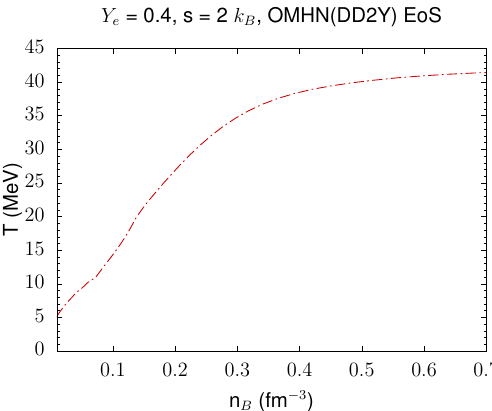
Figure 2. The temperature at constant entropy per baryon s = 2 k B and electron fraction Y e = 0.4 for the OMHN(DD2Y) EoS as function of baryon number